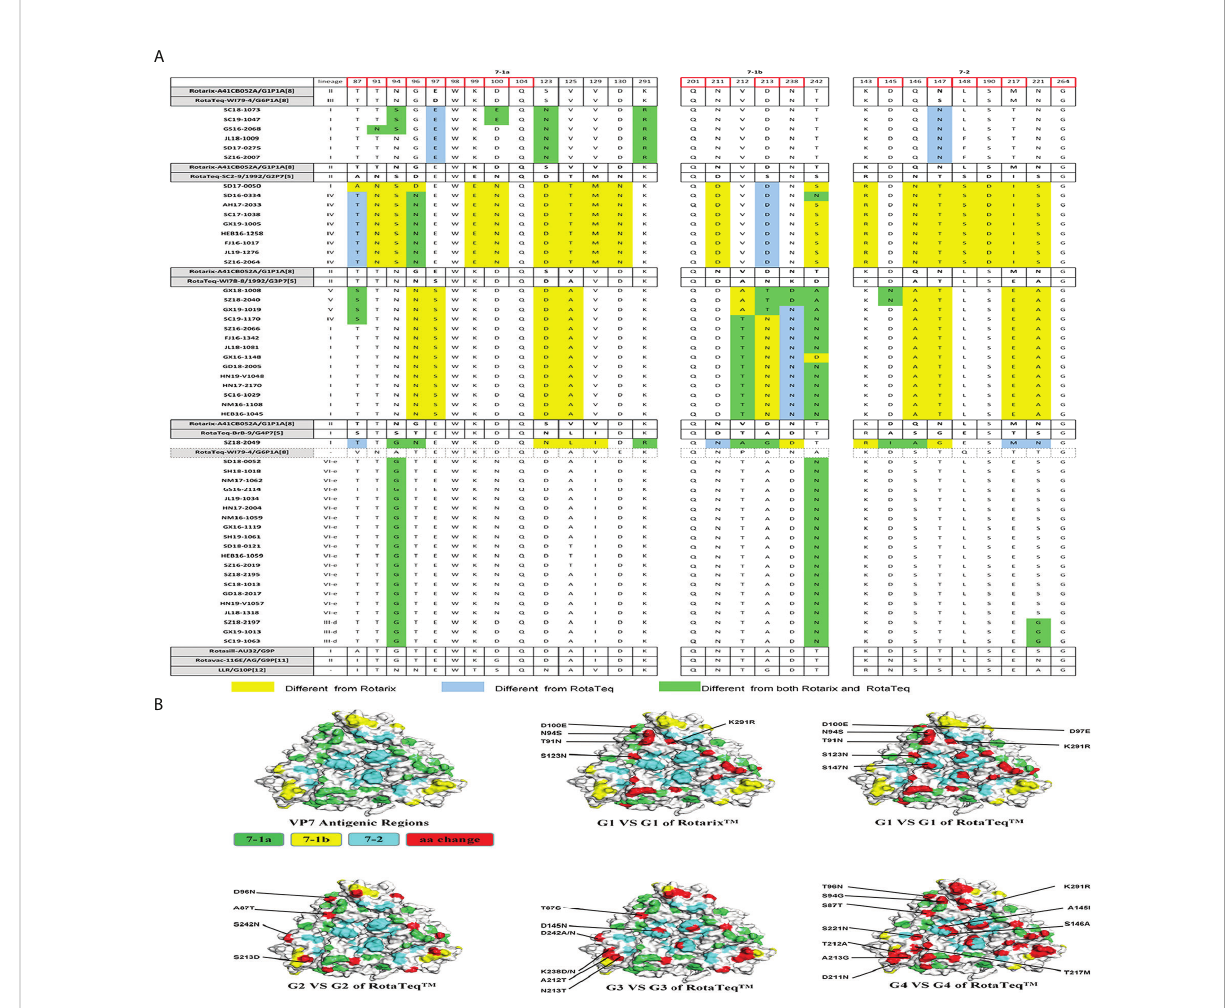
FIGURE 3 (A) Alignment of the antigenic epitopes in VP7 of the RVA strains circulating in China with those in Rotarix, RotaTeq, and other vaccines. Red box, the sites involved in neutralization escape. (B) Surface representation of the VP7 trimer (PDB 3FMG). Antigenic epitopes are in lime green (7-1a), yellow (7-1b), and cyan (7-2). Red, the surface-exposed residues that differ between circulating and vaccine RVA